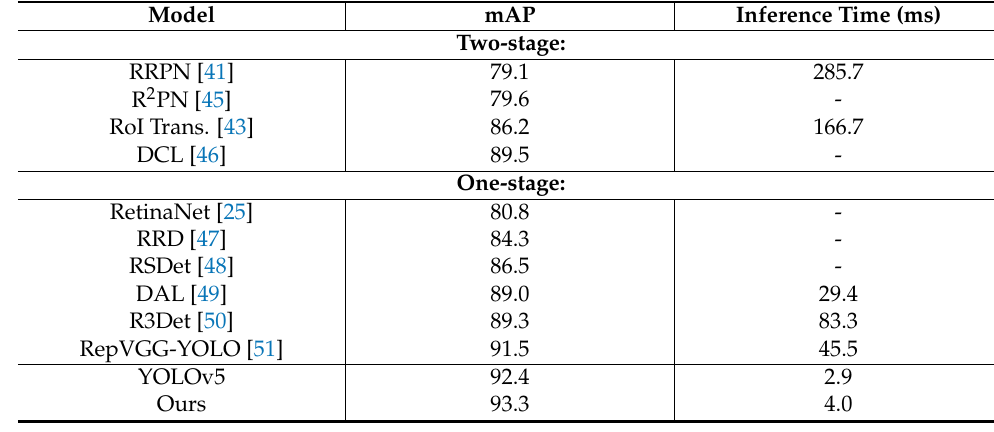
Figure 12. Loss Curve on the HRSC2016 dataset. 4.4. Visualization Results The visualization results of the model on the DOTA dataset are shown in Figure 13. Figure 13(a1 – a4) displays the objects with a small size; Figure 13(b1 – b4) reviews the ob- jects with different sizes in RSIs; Figure 13(c1 – c4) demonstrates the instances in complex backgrounds; Figure 13(d1 – d4) shows the detection effect of densely arranged objects. As